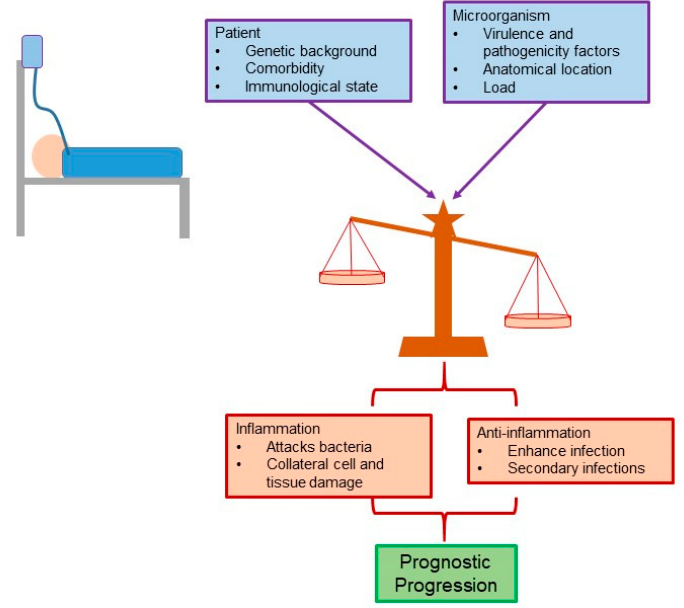
Figure 3. The clinical characteristics and pathophysiology of sepsis are multifactorial in